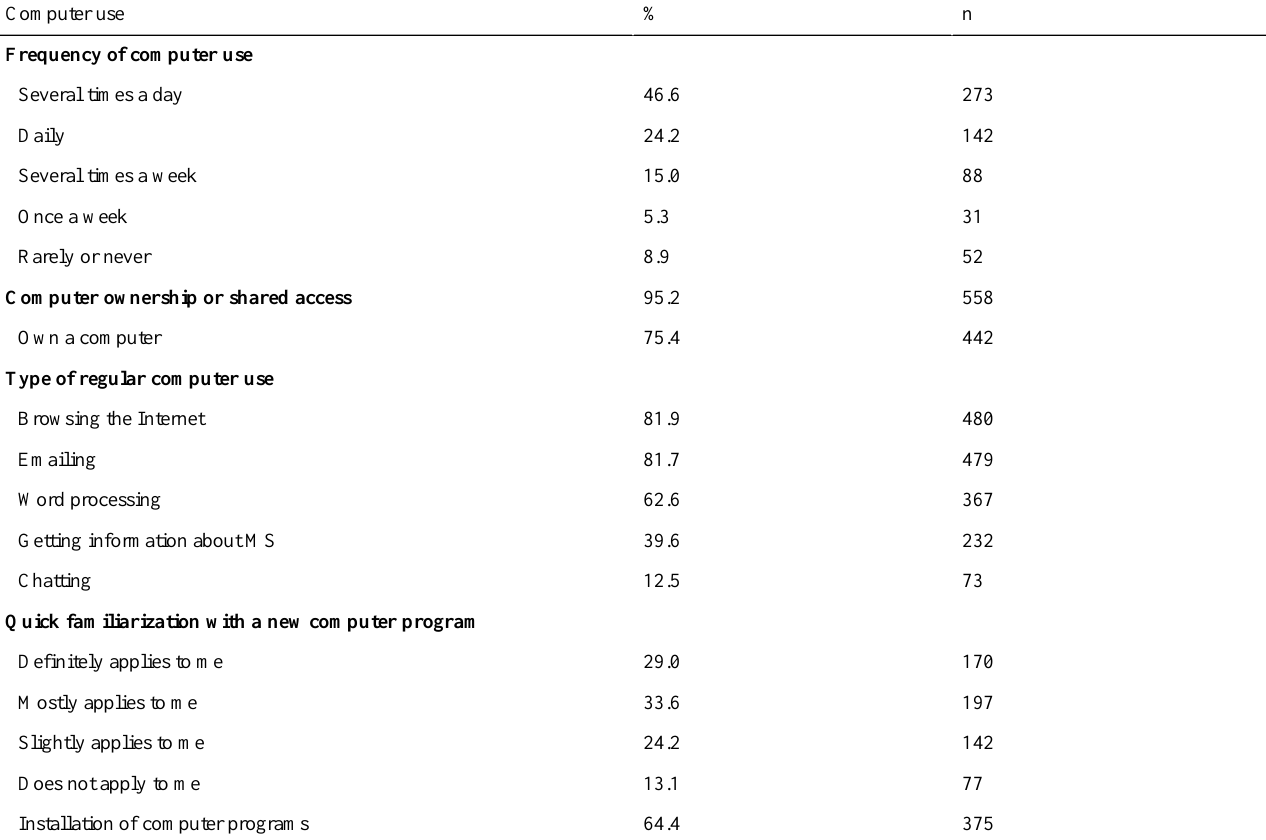
Table 1. Computer use by patients with multiple sclerosis (MS) (n =